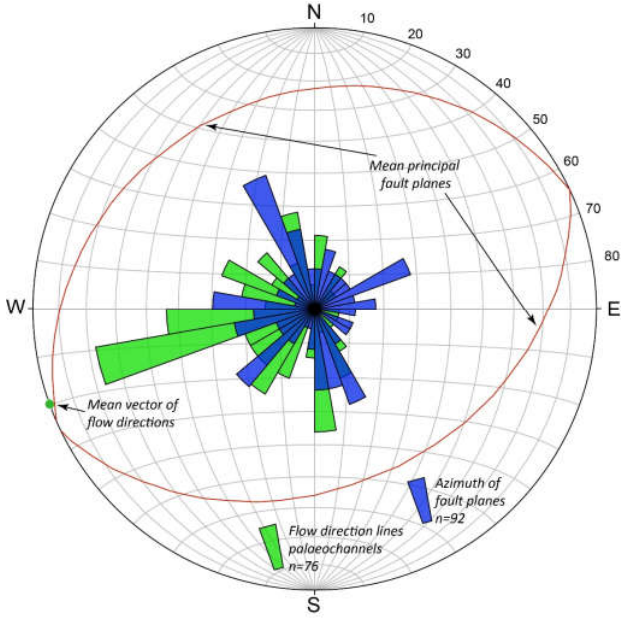
Figure 15. Projection of dip azimuth of NE-SW-striking fault planes and palaeochannel flow directions (opposite of pebbles dipping upstream) on an equal area rose diagram. Mean vector of flow directions (SW-W) versus mean dip azimuth of fault planes (NW-SE) are shown to indicate the preferred water flow orientation in palaeochannels.